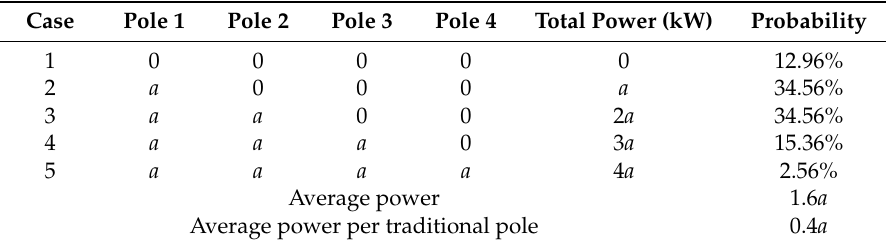
Table 5. Average power of 4 traditional poles under the condition of binomial distribution. Case Pole 1 Pole 2 Pole 3 Pole 4 Total Power (kW) Probability